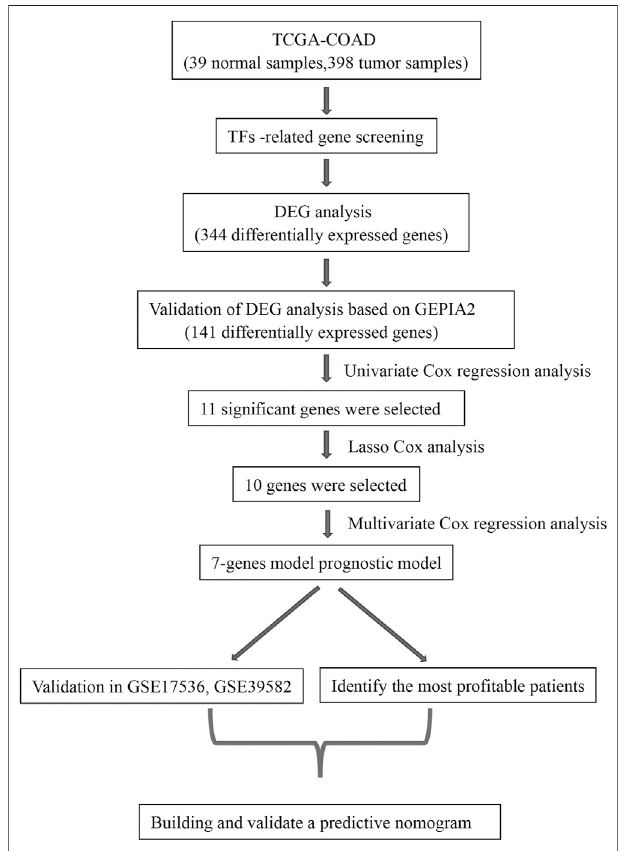
FIGURE 1 | The work fl ow to construct the transcription factor (TF)- related risk model in COAD patients. TCGA, The Cancer Genome Atlas; COAD, colon adenocarcinoma; DEG, differentially expressed gene; GEPIA2, Gene Expression Pro fi ling Interactive Analysis 2.